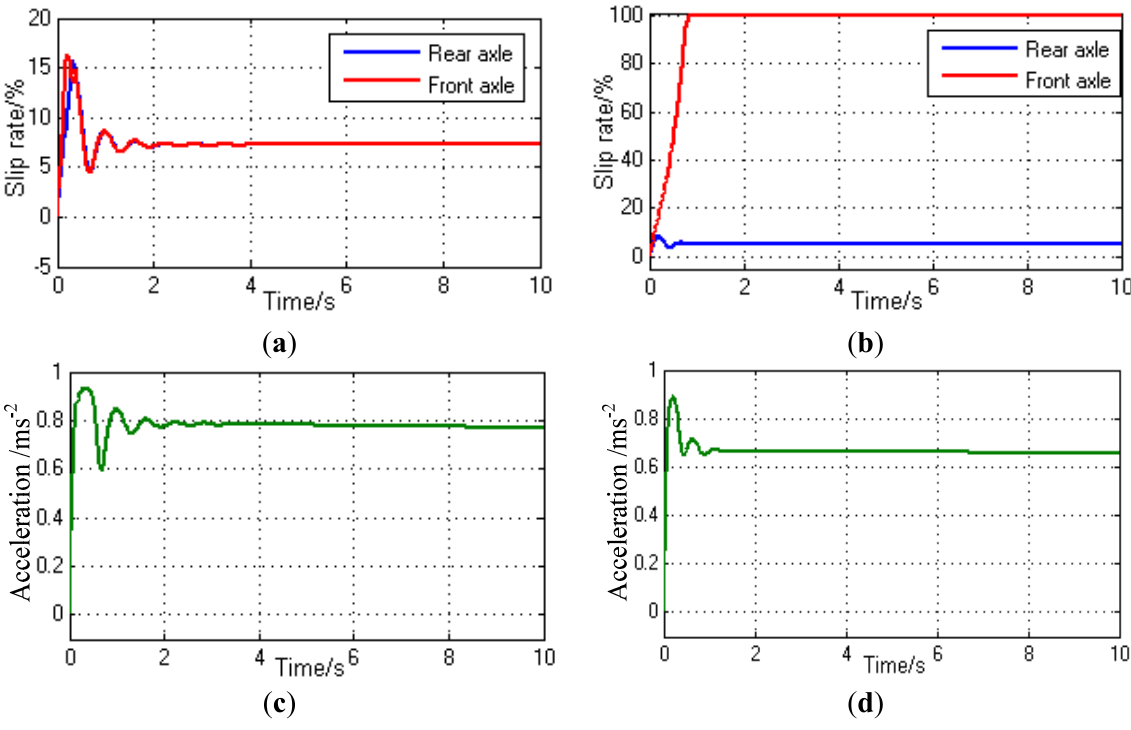
Figure 7. Simulation of stepping on the pedal lightly to accelerate on a mid-adhesion road: ( a ) Optimal torque of inter-axle distribution control; ( b ) Average torque distribution control; ( c ) Acceleration under optimal torque of the inter-axle distribution control; ( d ) Acceleration under the average torque distribution